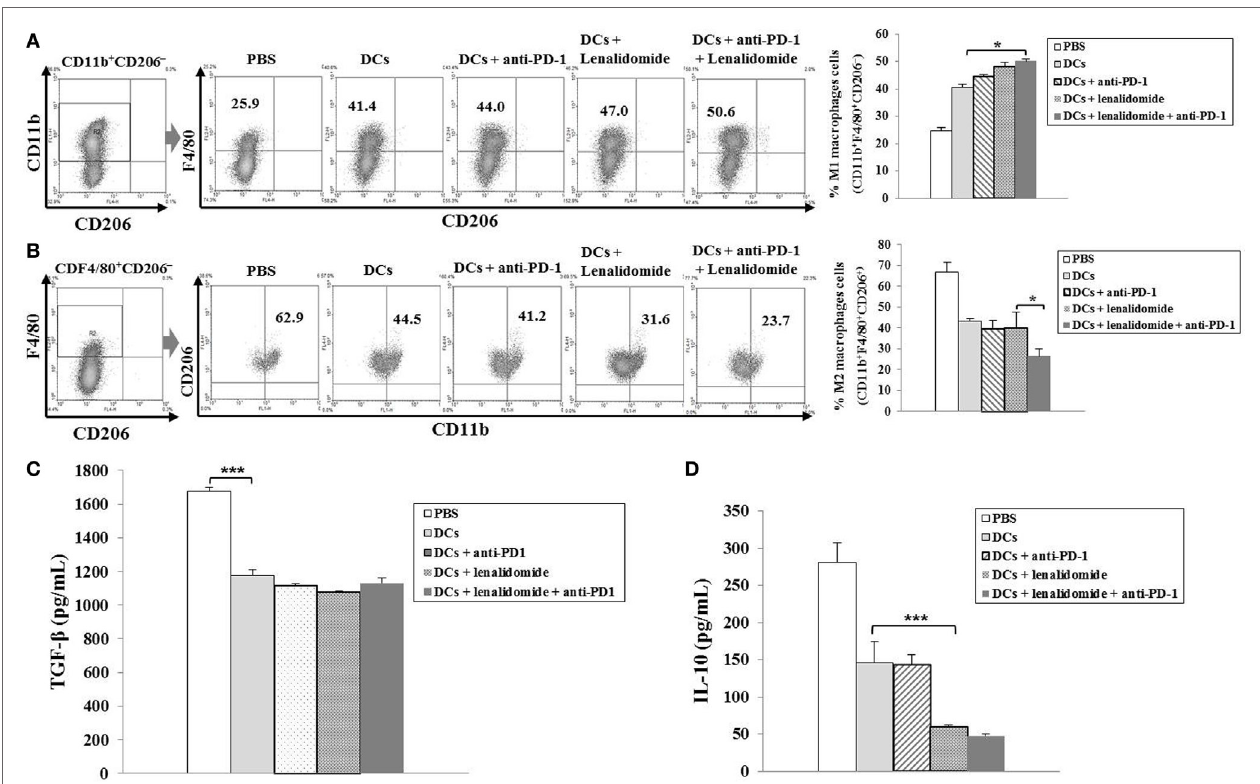
FigUre 5 | Enhanced M1 and impaired M2 macrophage polarization and reduced inhibitory cytokine production via vaccination with dendritic cells (DCs) plus lenalidomide and anti-PD-1 We measured proportions of (a) M1 macrophages (CD11b + F4/80 + CD206 − ) and (B) M2 macrophages (CD11b + F4/80 + CD206 + ) in the spleens of vaccinated tumor-bearing mice using flow cytometry (left panel) and compared them using quantitative bar graphs (right panel). The DCs plus lenalidomide and anti-PD-1 combination group exhibited the highest proportion of M1 macrophages and the lowest proportion of M2 macrophages compared to the other groups (* P < 0.05). Data are representative of three independent experiments. The production of (c) TGF- β and (D) IL-10 inhibitory cytokines in the tumors of tumor-bearing mice was evaluated by enzyme-linked immunosorbent assay. Compared to the treatments, PBS control led to the production of higher levels of TGF- β (*** P < 0.001). However, the production of TGF- β did not differ significantly among the treatment groups. The production of IL-10 was significantly decreased in the DCs plus lenalidomide and anti-PD-1 combination therapy group compared to the other groups (*** P < 0.001). Data are representative of at least three